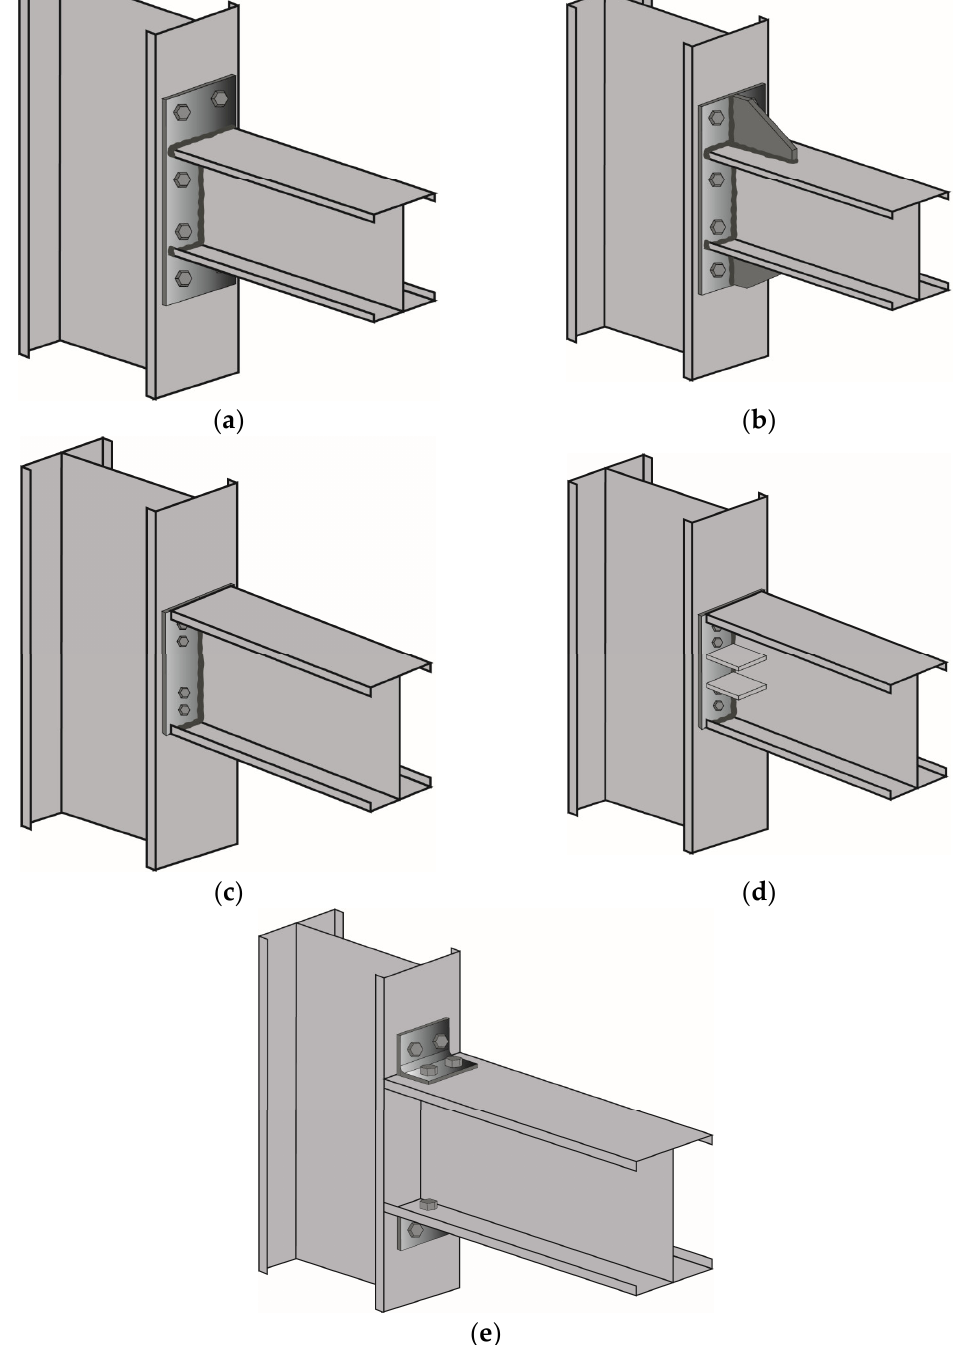
Figure 3. A visual sketch of typical ( a ) unstiffened Extended End-Plate, ( b ) stiffened Extended End-Plate, ( c ) unstiffened Flush End-Plate, ( d ) stiffened Flush End-Plate and ( e ) Top-and-Seat Angle Cleat.